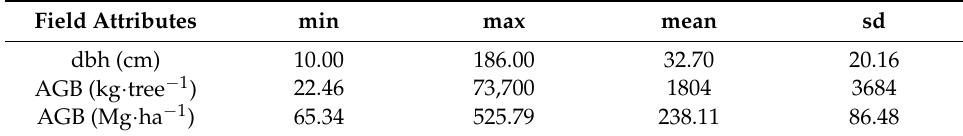
Table 1. Summary of the AGB stocks at the sample plots.